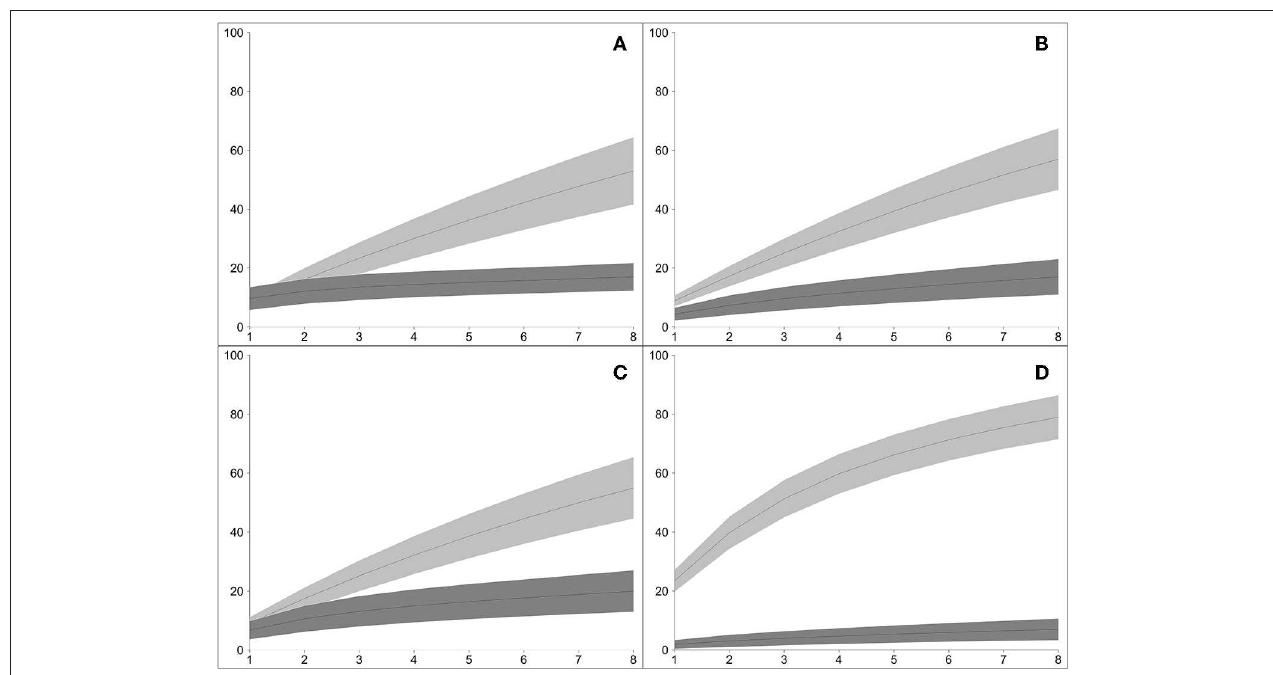
FIGURE 2 | Bootstrapped rarefaction curves of the accumulation of species of lichenized fungi, comparing WGS-based rDNA approach (light gray bands) vs. amplicon-based ITS1 approach (dark gray bands), in the four sampling regimes in two plots: (A) high-elevation rock samples; (B) low-elevation rock samples;